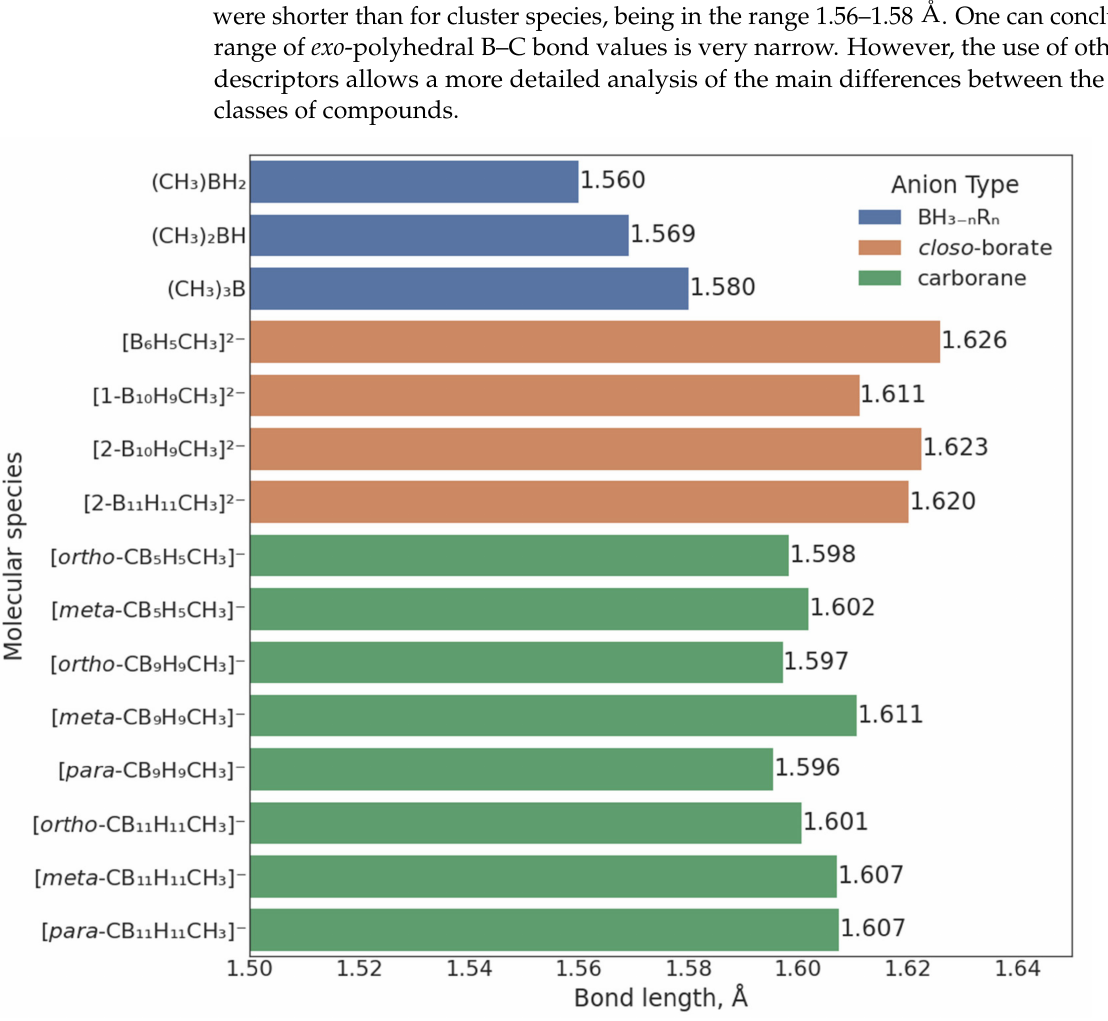
Figure 2. Correlation matrix of main B–C bond descriptors in closo-borate anions of the general form [B n H n − 1 CH 3 ] 2 − (n = 6, 10, 12), monocarboranes [CB n H n CH 3 ] − (n = 5, 9, 11) and BH 3 − n (CH 3 ) n (n = 1–3). For monocarboranes, only exo -polyhedral B–C bonds were considered.